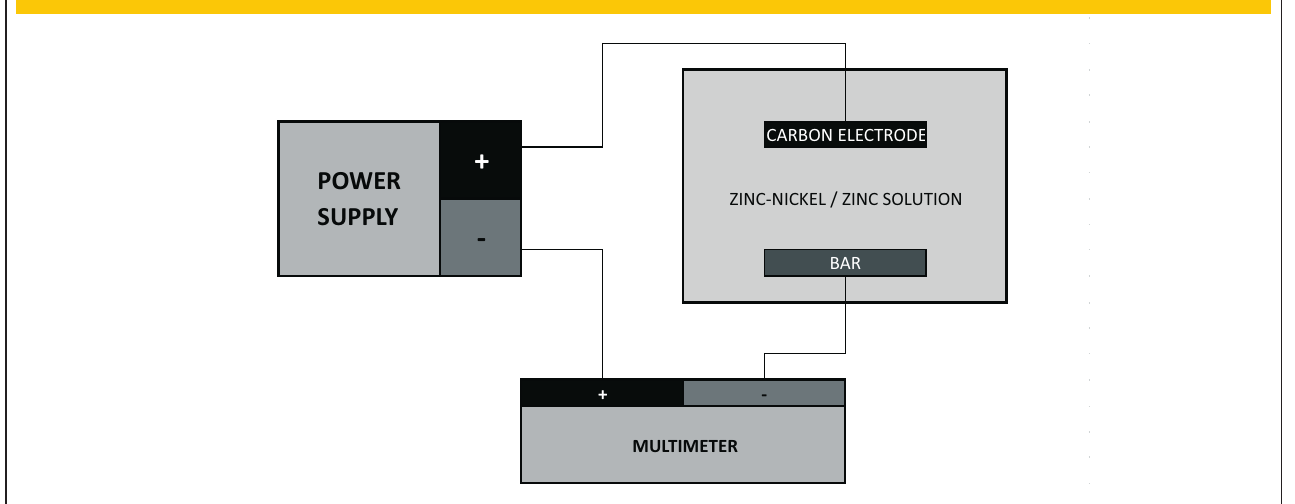
Figure 1 – Representation of electric circuit used for the bars